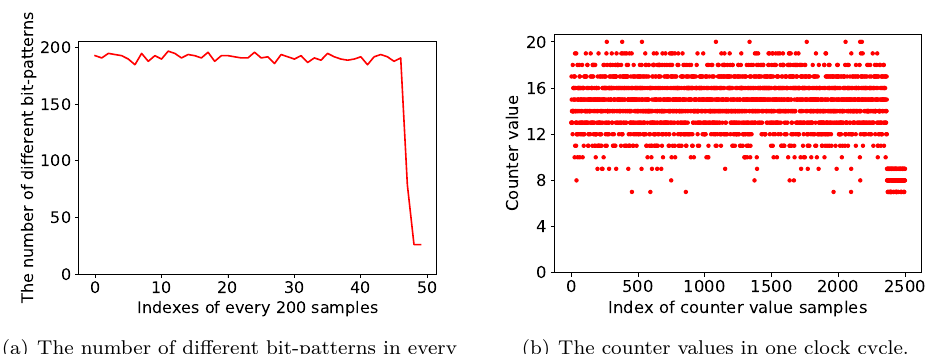
Figure 25: The measured sampling results of bit-patterns and the counter values.